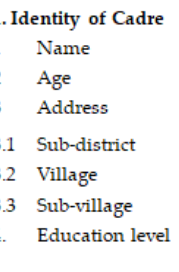
Figure 2. Flow diagram of intervention stage.